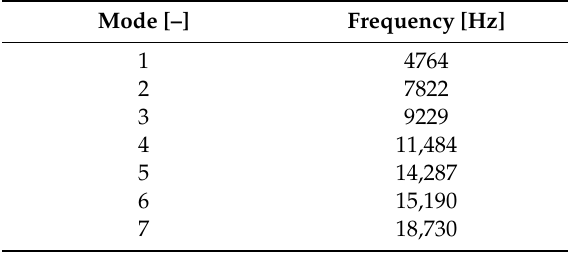
Table 1. Calculated natural frequencies of the blade segment.